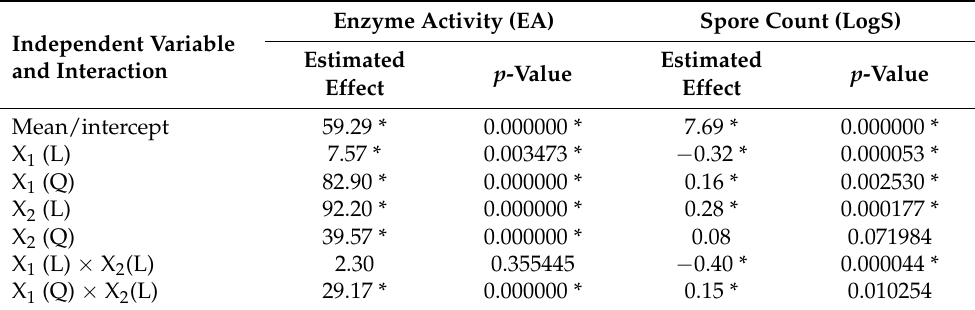
Table 3. Estimated effects of the variables temperature (X 1 ) and time (X 2 ) on enzyme activity and spore count.